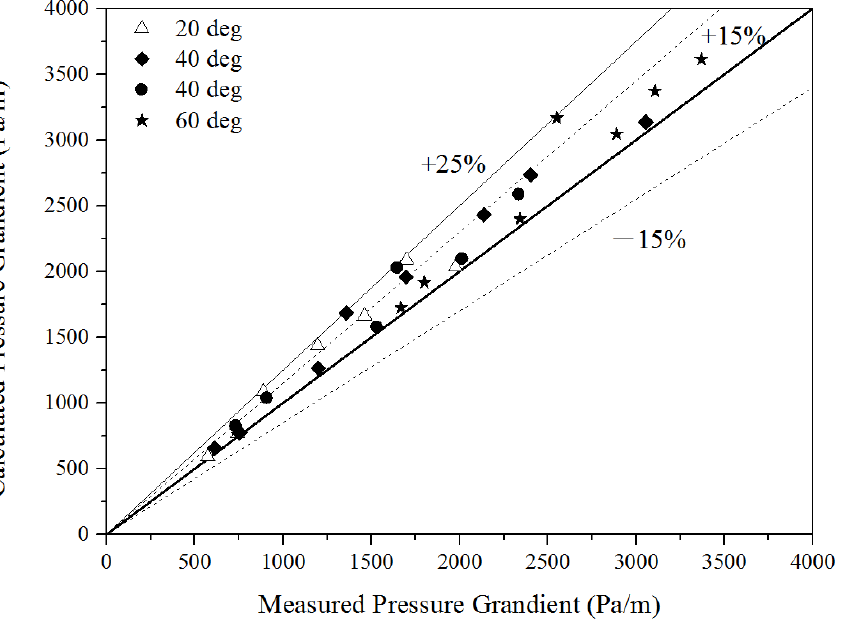
Figure 7. Comparison of the prediction and experiment for pressure gradient for the No. 2 experi- ment.